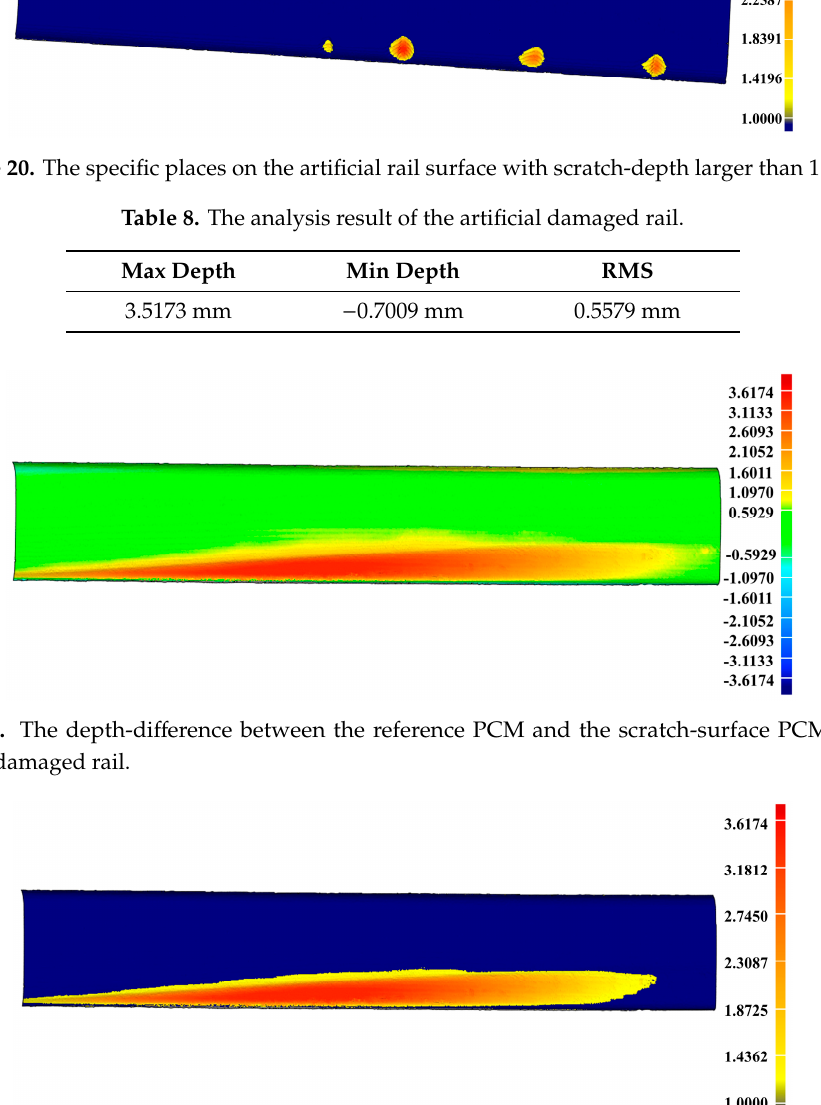
Figure 22. The specific places on the practical damaged rail surface with scratch-depth larger than 1 mm . Table 8. The analysis result of the artificial damaged rail.